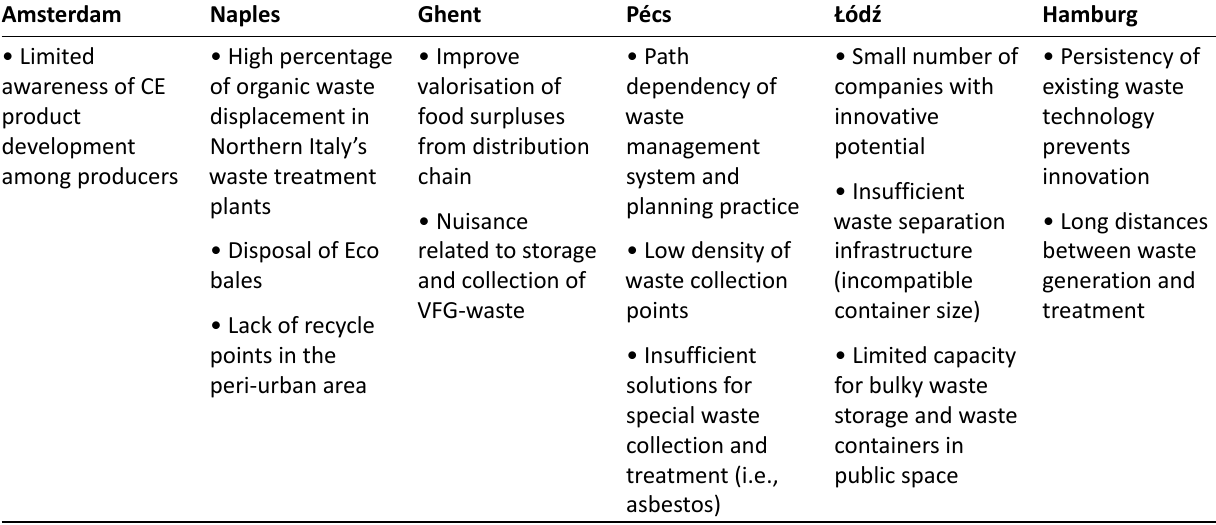
Table 5. Governance challenges: Technological/infrastructure.